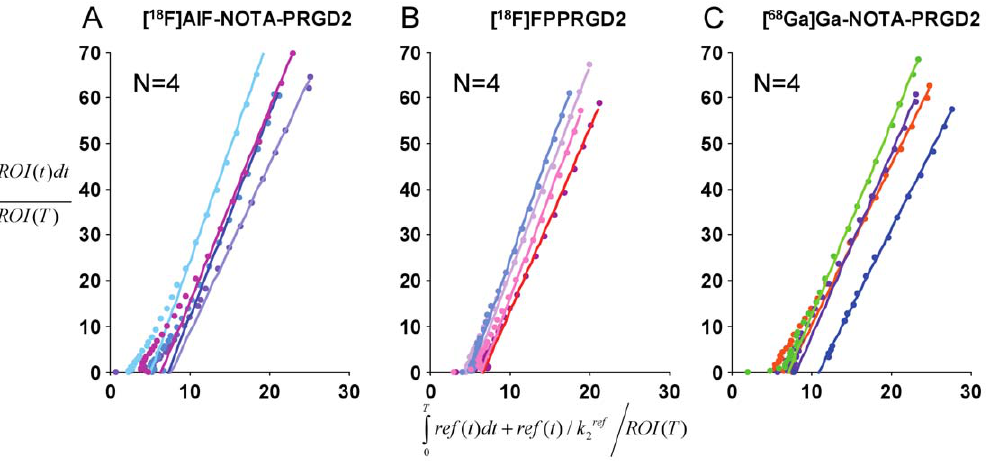
Figure 5. Logan graphical analysis fitting to 60-min dynamic microPET data, which showed excellent linearity of normalized integrated (Int) tumor activity vs. normalized integrated muscle tissue activity effective for time . 30 min. Slopes of fits represent DVRs. doi:10.1371/journal.pone.0037506.g005 PLoS ONE |